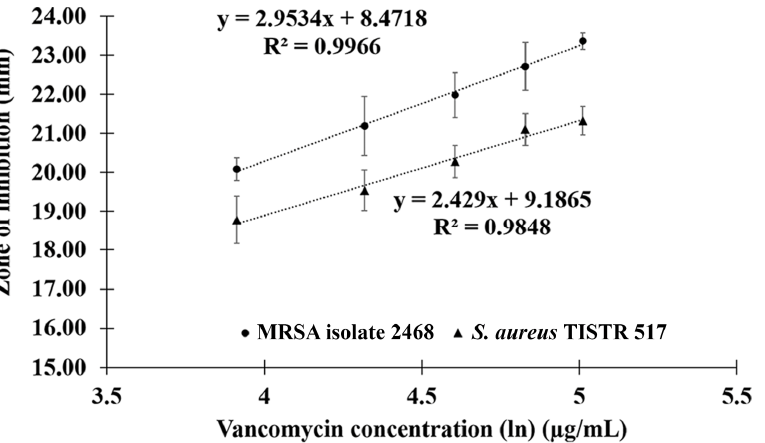
Figure 5. The standard curve for potency comparison between anti-MRSA peptide (P1) and vancomycin. The curve was constructed by plotting between vancomycin concentrations and zone of inhibition against S. aureus TISTR 517 and MRSA isolate 2468. Table 5. Potency comparison between anti-MRSA peptide (P1) and vancomycin. The inhibition zones of P1 and vancomycin in the agar well diffusion test were measured, and the results are presented as mean ± SD.